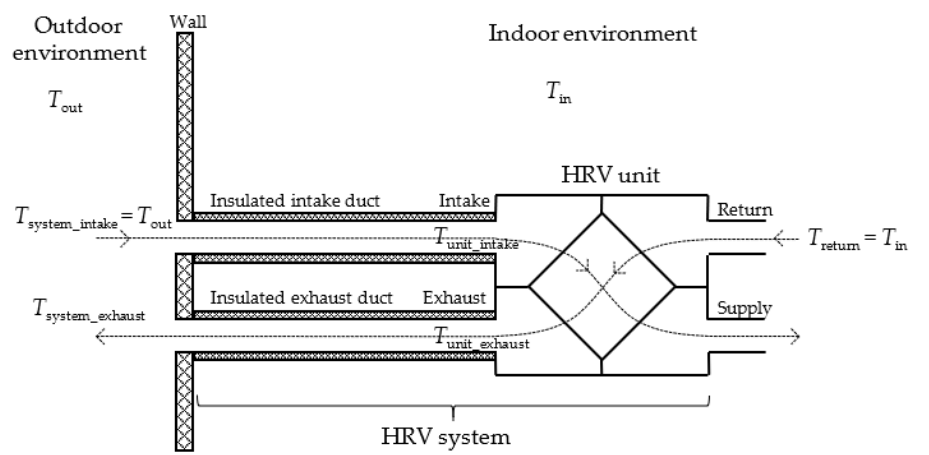
Figure 1. Conceptual drawing of the heat recovery ventilator (HRV) system. The HRV system consists of an HRV unit and insulated intake and exhaust ducts. See the Nomenclature section for the meanings of the shown variables.